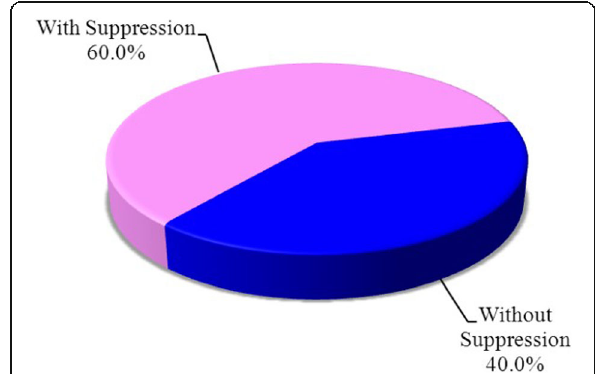
Fig. 2 Percentage of TEOAE suppression in tinnitus ears (according to suppression